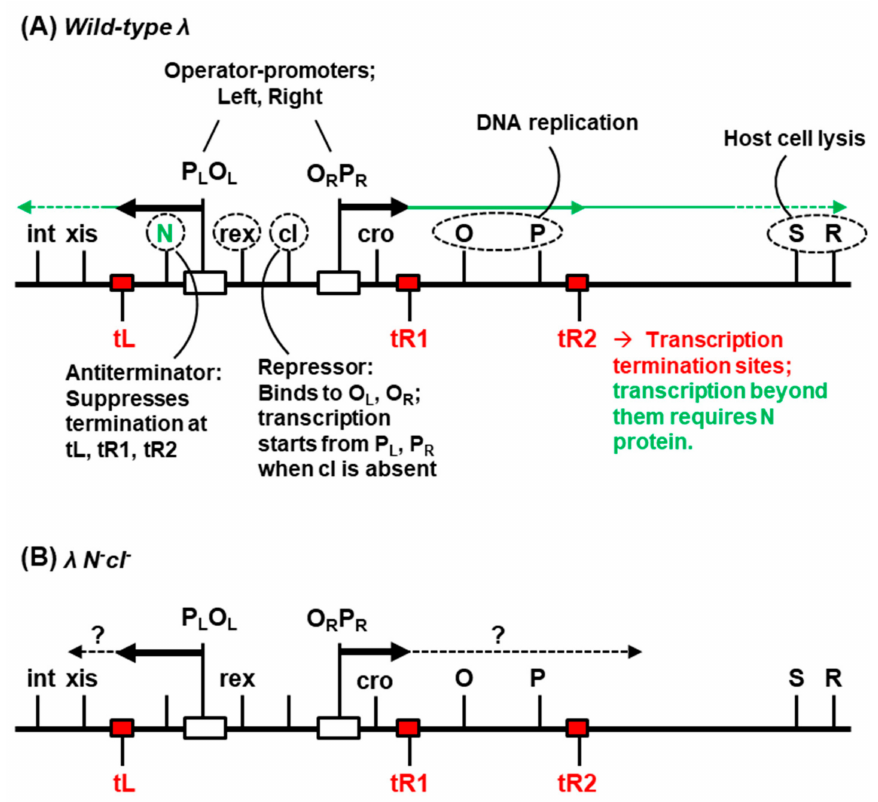
Figure 1. Selected gene and sites in the phage λ genome [2]. Transcription of λ DNA uses host RNA polymerase and is regulated negatively by the transcriptional repressor, cI, and positively by the antiterminator protein, N. In the lytic cycle ( A ), the operators ( O L , O R ) are unoccupied by cI, and leftward and rightward transcription start from the respective promoters, P L and P R . If N is unavailable, ~90% of the transcription [8] initiated from P L and 60% of that initiated from P R stops at the termination sites, t L and tR 1, respectively, while the 40% that passes through tR 1 completely stops at tR 2 (shown in red). In the presence of N protein, the RNA polymerase is modified so as to ignore the termination sites, which allows transcription to proceed downstream (green arrows). Thus, λ N - mutant cannot grow productively. The λ N - c I - double mutant presents a special combination in that it forms the unique polylysogen that is studied in the paper. In this state ( B ), transcription is initiated from both P L and P R , since the c I repressor is inactive, but the bulk of the transcription fails to pass the terminators as described above. Several other regulatory genes with accessory functions are not shown for